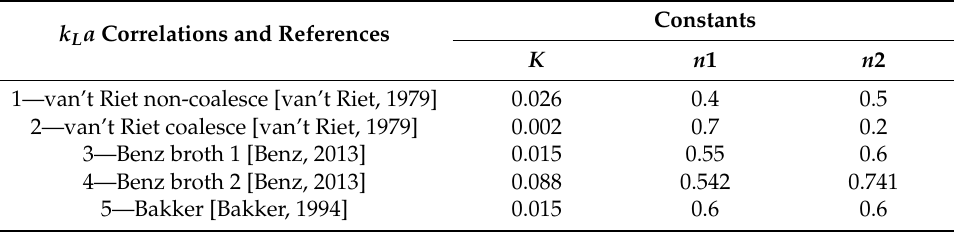
Table 2. Values of constants in k L a correlations.